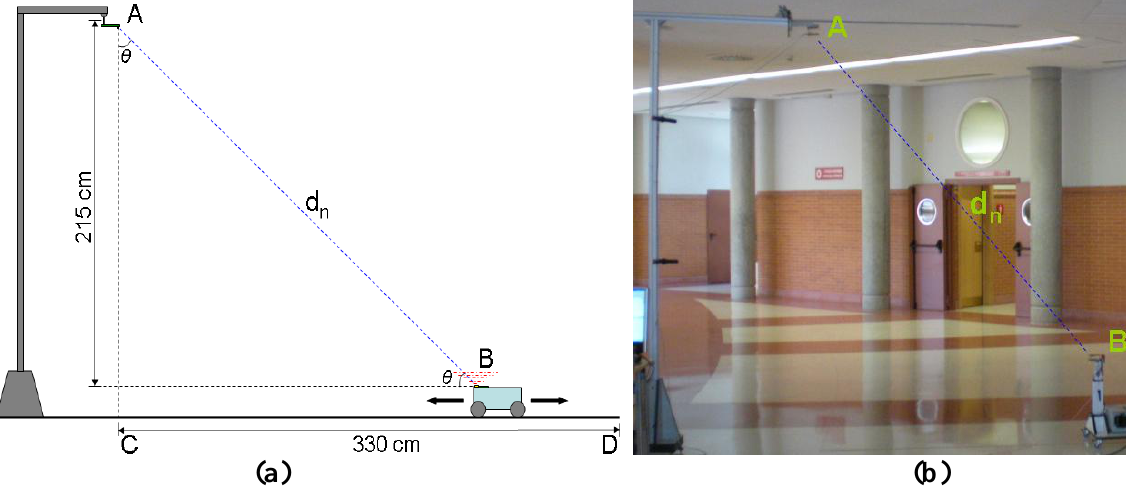
Figure 14. Setup for distance measuring using one receiver. (a) Setup diagram; (b) Actual